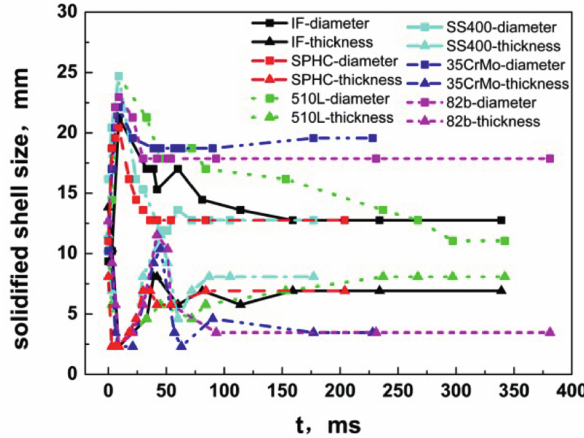
Figure 8: Diameter and thickness of solidified shell changes over time during the